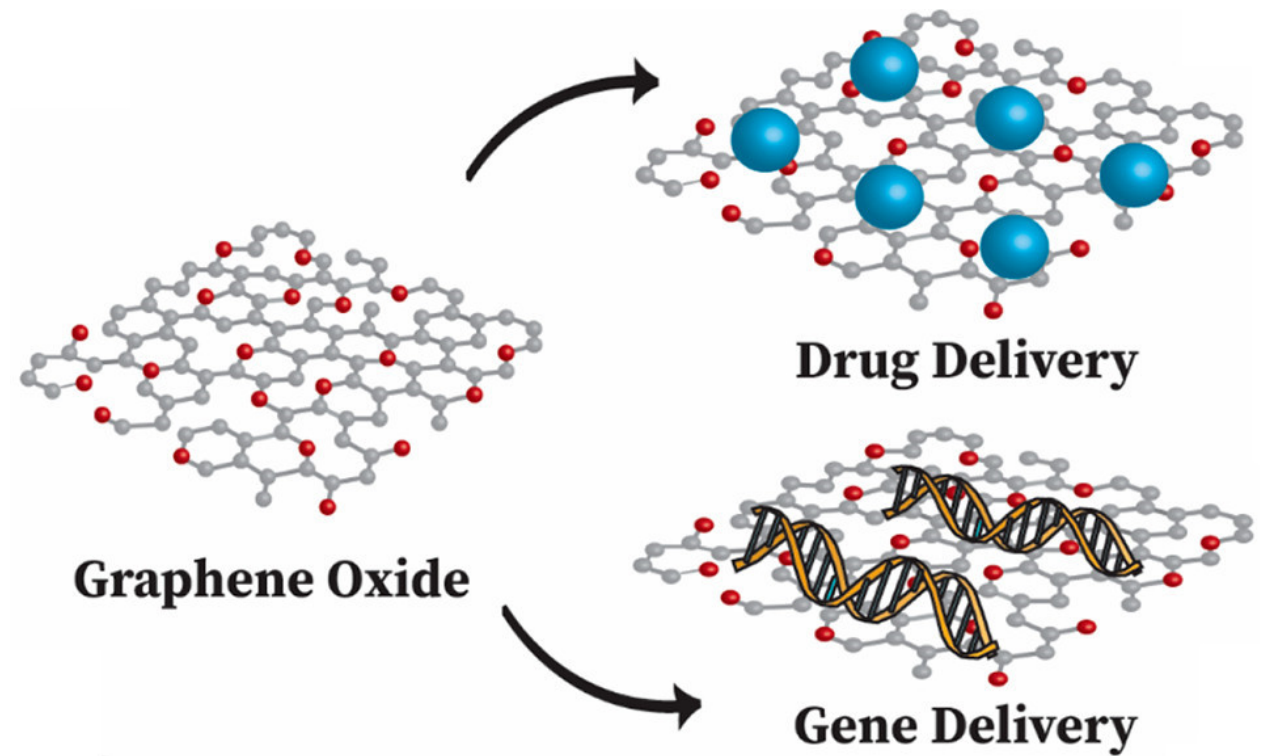
Figure 11. Schematic of drug and gene delivery from graphene oxide Reproduced with permission from Ref. [210]. Copyright 2021 the American Chemical Society.